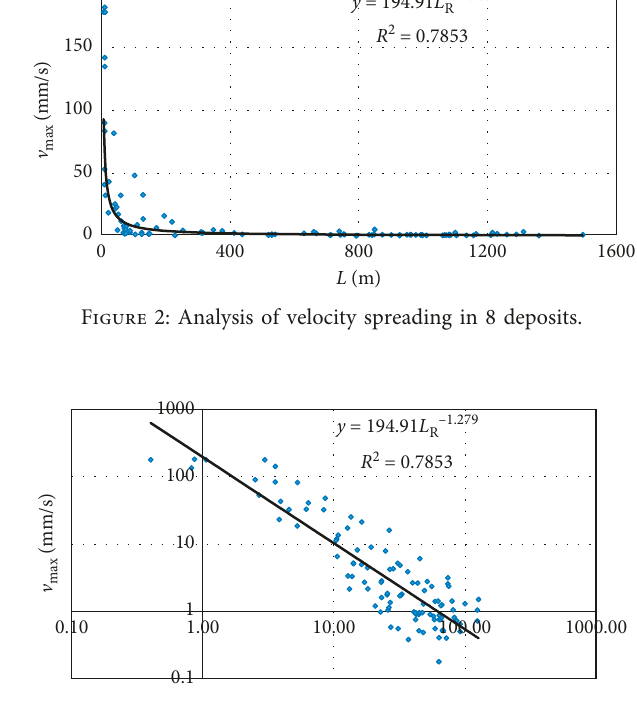
One-way analysis of v max by deposit